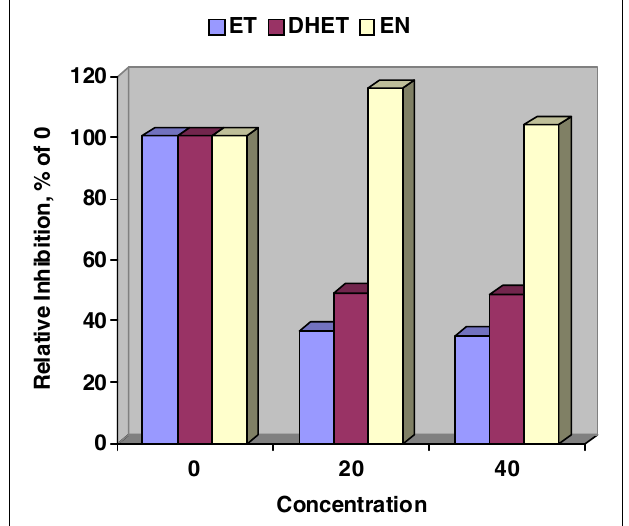
FIGURE 1 | Relative inhibition of in vitro cytochrome P450 activity by ergotamine (ET), dihydroergotamine (DHET), and ergonovine (EN). Interaction between alkaloid and concentration ( µ M) affected ( SE = 4 . 67 ; P < 0 . 001 ) P450-Glo assay luminescence. Concentration of EN did not affect relative inhibition. Within ET and DHET 20 and 40 µ M concentrations did not differ.